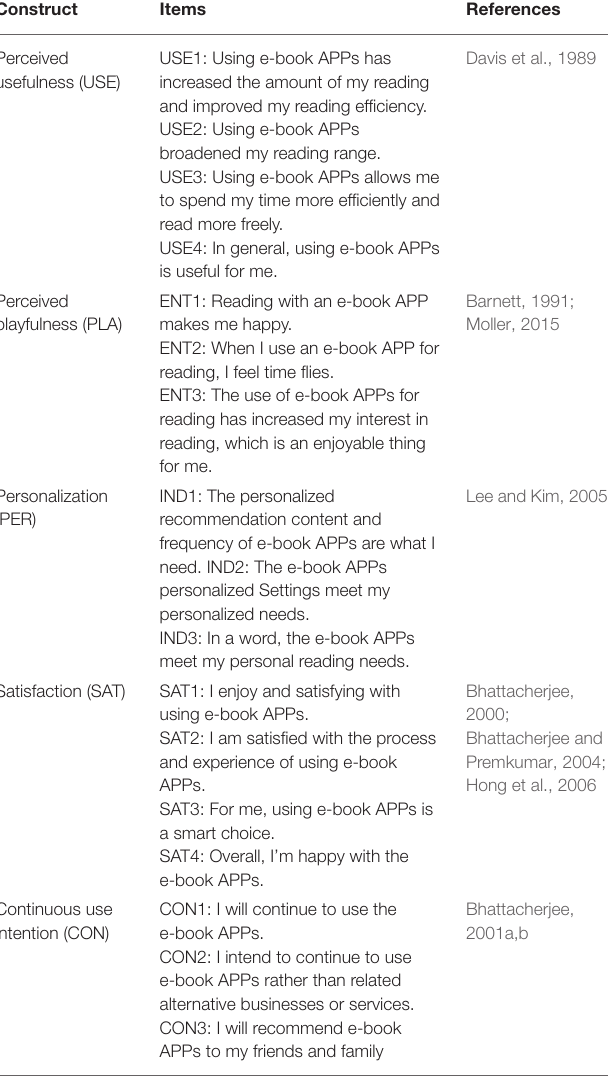
TABLE A1 | Questionnaire of